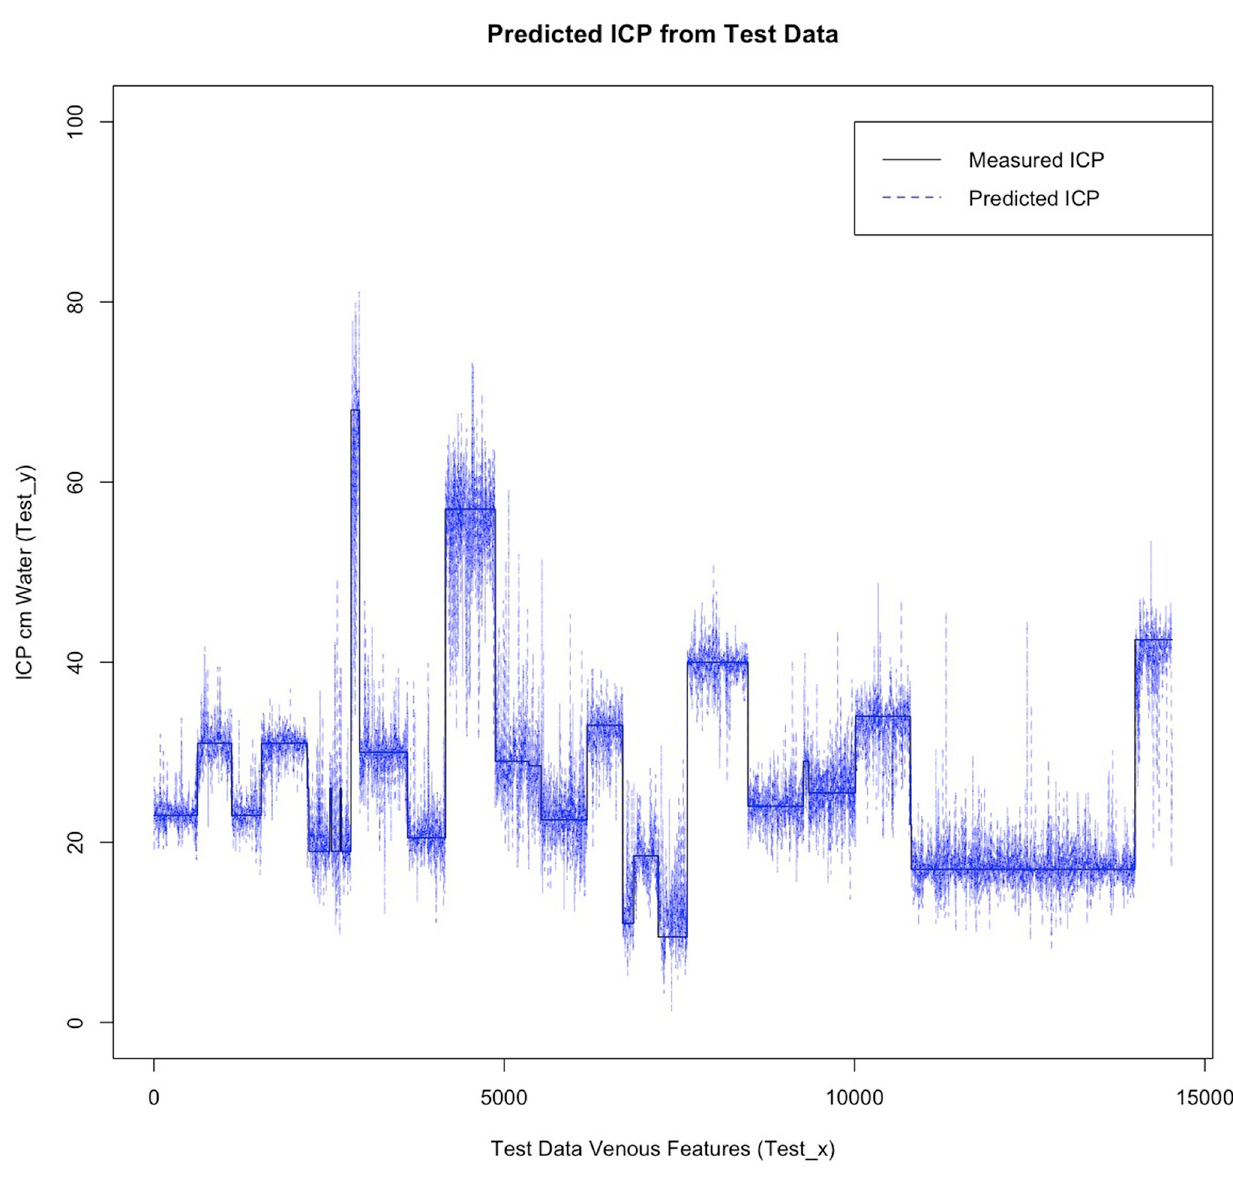
Fig 6. Retinal venous model fit. The venous model was composed of a total of 451 nodes, 450 edges, and 35,589 leaves. The model had a higher R 2 of 0.91, other accuracy parameters were: MSE = 11.85, MAE = 2.11, RSME =